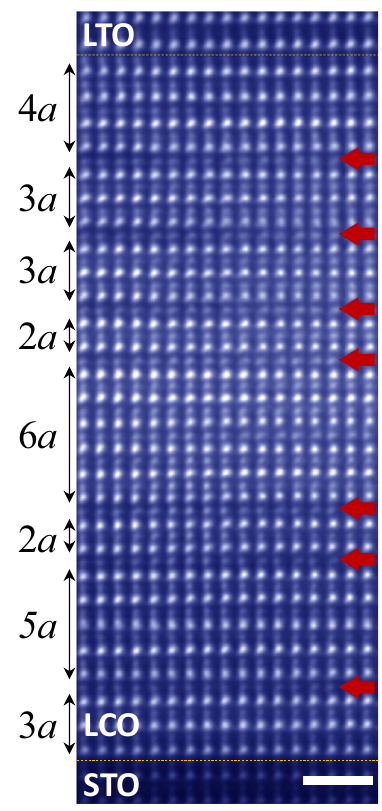
Fig. 5 Nonuniform distribution of CoO 4 layers in C28/T7. HAADF-STEM image of C28/T7 taken along the STO [110] direction. The scale bar corresponds to 1 nm. The red arrows indicate the CoO 4